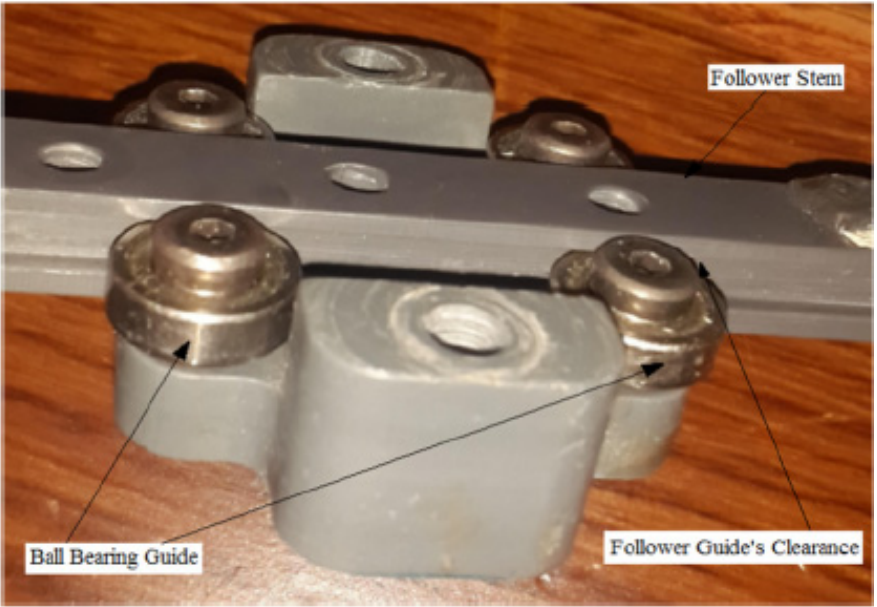
Figure 17. Experiment simulation of internal distance of the follower guide with clearance.